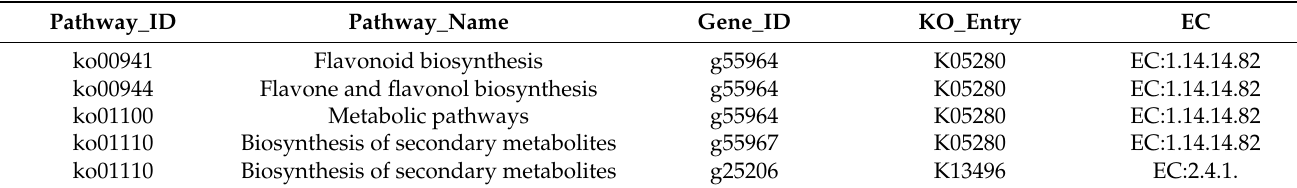
Table 4. KEGG analysis of candidate genes related to the RNA-seq results.